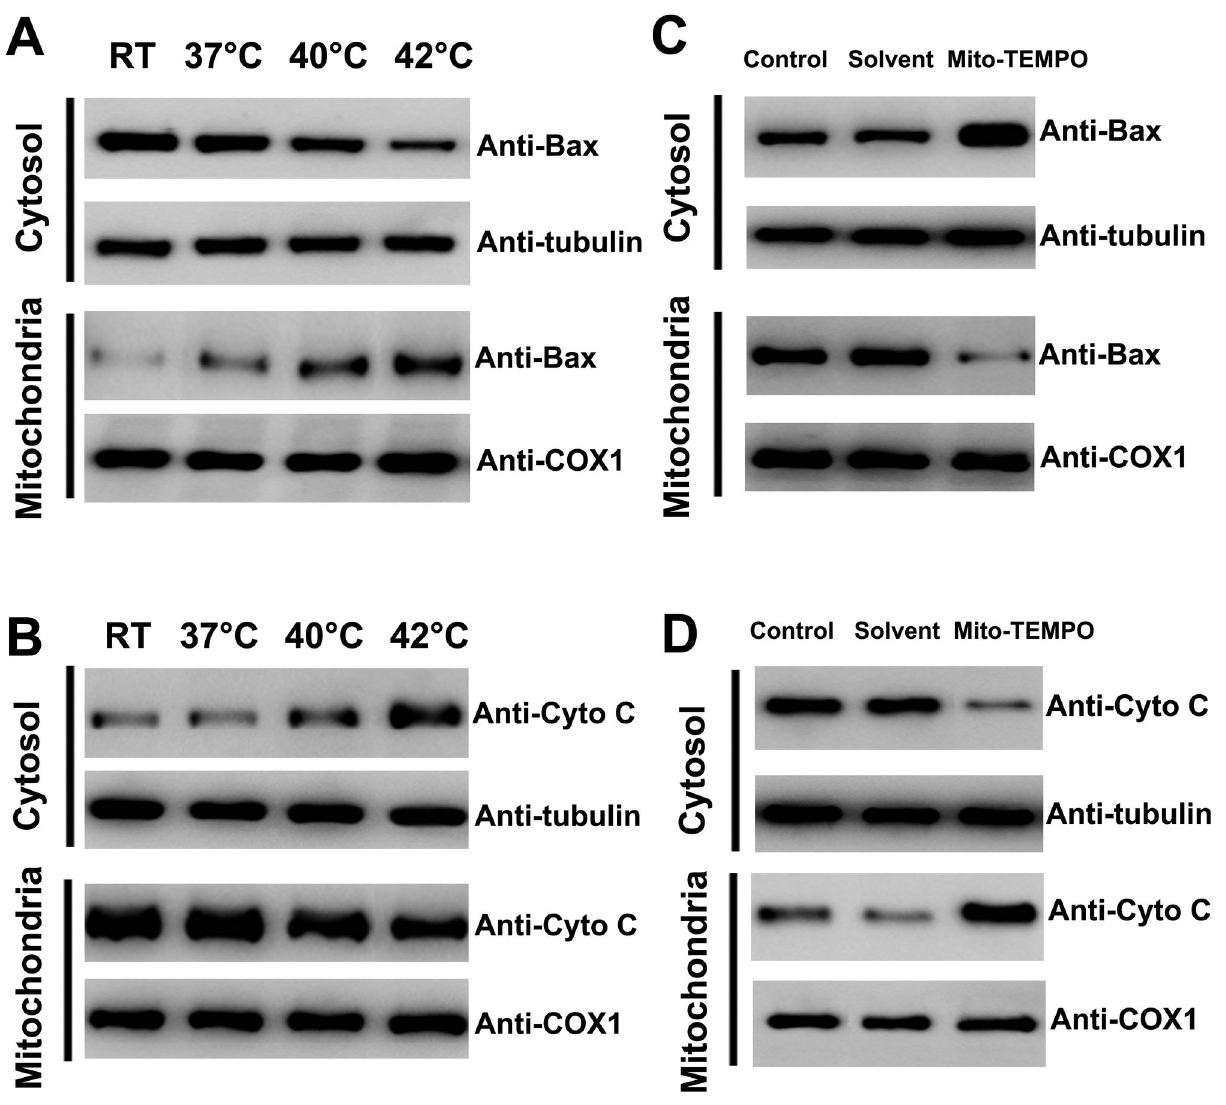
Figure 4. Effect of Mito-TEMPO on Bax mitochondrial translocation and cytochrome C release in hyperthermia-treated platelets. (A–D) Washed platelets were incubated at different temperatures for 3 h (A and B), or pre-incubated with Mito-TEMPO and solvent control at 37°C for 15 min and then incubated at 42°C for 3 h (C and D). Treated platelets were lysed, and cytosol and mitochondrial fractions were isolated and analyzed by Western blot with anti-Bax (A and C), and anti-cytochrome C (B and D). Cytochrome C oxidase subunit 1 (COX1) and tubulin were used as internal controls. Representative data of three independent experiments are presented. Cytochrome C is labeled as Cyto